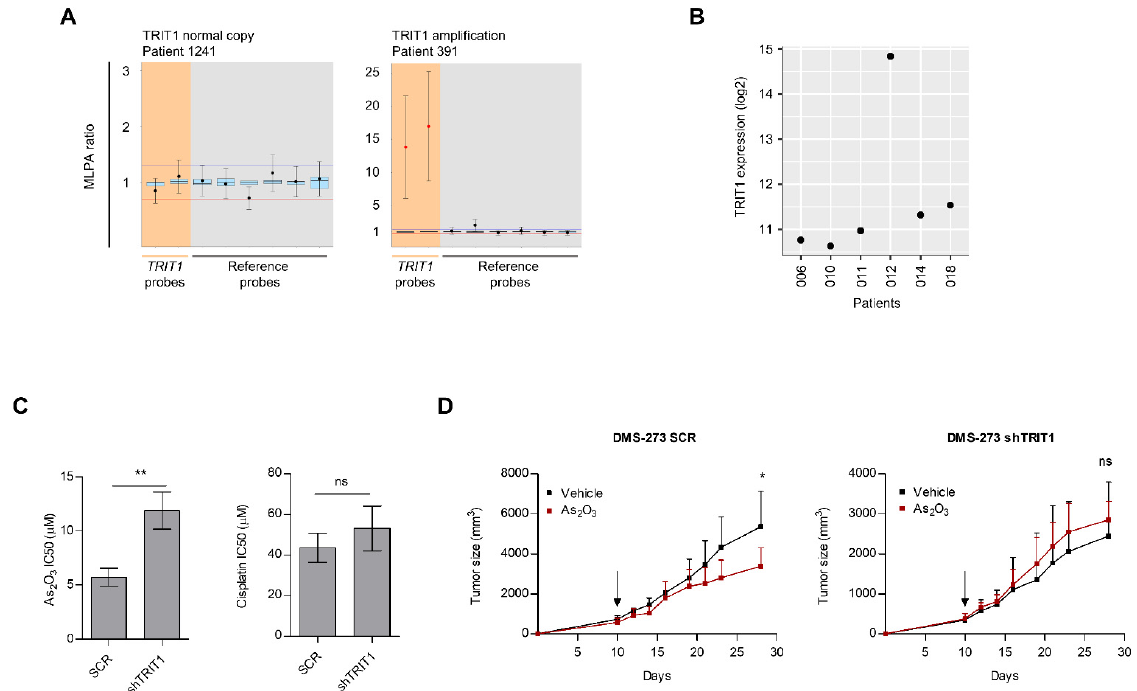
Figure 3. TRIT1 gene amplification in primary small-cell lung cancer patients and response to arsenic trioxide. ( A ) MLPA assay of primary small-cell lung cancer samples. Probe mixes contained two probes for exons 4 and 9 of the TRIT1 gene (in orange). Six reference probes were also included (in grey). Values greater than 2 (two copies, corresponding to MLPA ratio of 1) were considered to indicate the presence of extra copies. Patient 1241 is shown as example of a TRIT1 two copy number case, whilst patient 391 shows TRIT1 gene amplification. ( B ) TRIT1 RNA expression levels derived from Affymetrix U133Plus2.0 microarray data in six primary small-cell lung cancer samples where TRIT1 copy number was determined. The only patient that exhibited TRIT1 gene amplification (#012) showed the highest TRIT1 expression level. Two copies of TRIT1 were observed in the 006, 010, 011, 014 and 018 samples. ( C ) IC50 determination by MTT assay. TRIT1 shRNA-depleted DMS-273 cells were significantly less sensitive to the antiproliferative effect of arsenic trioxide than were the shRNA scramble-transfected cells harboring TRIT1 gene amplification-associated overexpression. TRIT1 shRNA-mediated depletion did not affect sensitivity to cisplatin. Student’s t test, ** p < 0.01; ns, non-significant. ( D ) shRNA scramble (SCR, left panel) and TRIT1 shRNA-depleted (shTRIT1, right panel) DMS-273 cells were injected into the flanks of nude mice to form subcutaneous tumors. Tumor volume over time according to treatment conditions, vehicle (black lines) vs. arsenic trioxide-treated group (red lines) are shown. Black arrow indicates the time at which the mice were randomized and started to be treated with arsenic trioxide or vehicle. P values are those corresponding to Student’s t tests. Means and standard deviations (bars) are illustrated. Tumors derived from shRNA scramble-transfected DMS-273 cells were sensitive to the growth inhibition effect of arsenic trioxide (left panel), whilst TRIT1 shRNA-mediated depletion eliminates the enhanced sensitivity to arsenic trioxide, the tumor size reduction effect being similar to that obtained with the vehicle treatment (right panel). * p < 0.05; ns, non-significant.